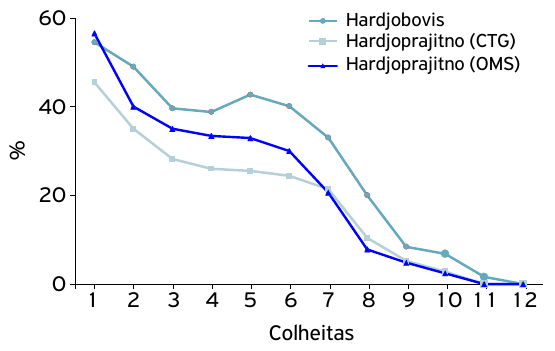
Tabela 2. Reagentes para sorovares de Leptospira spp. em